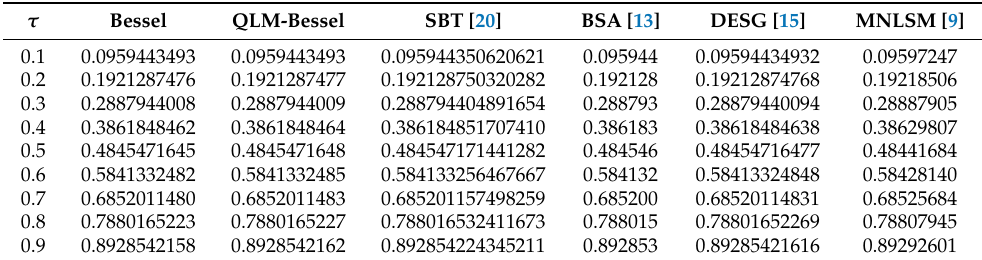
Table 1. Comparison of numerical solutions in Bessel/QLM-Bessel for Test case 1 using M = 9 and [ 0,1 ] . various τ ∈